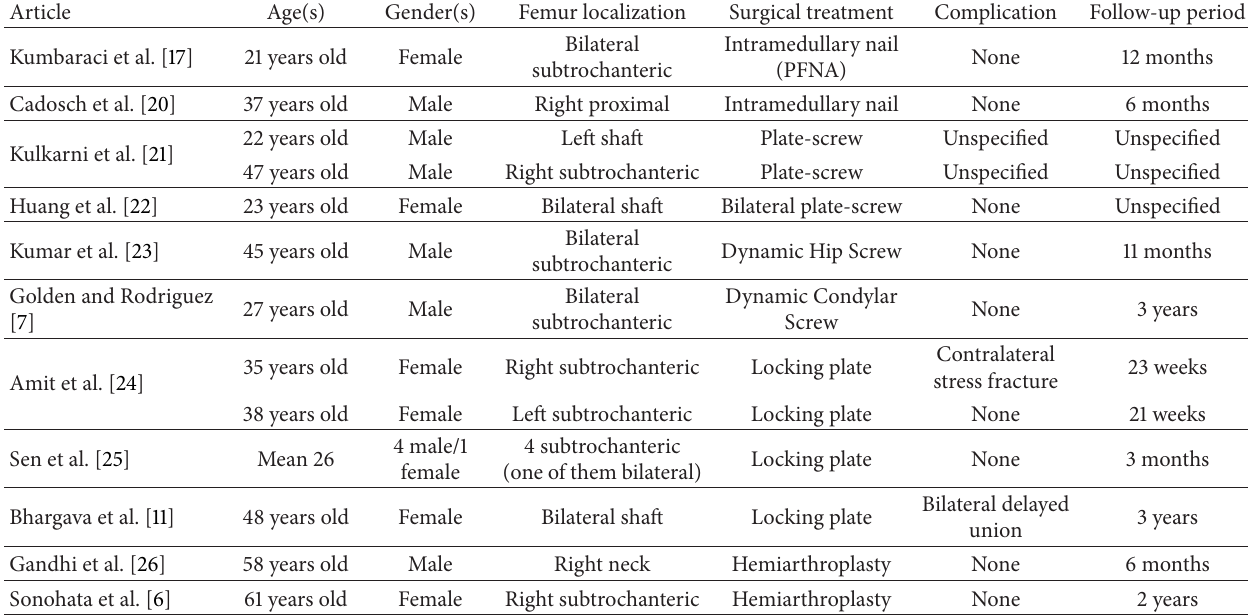
Table 1: Osteopetrotic femur fractures were treated surgically: the published cases